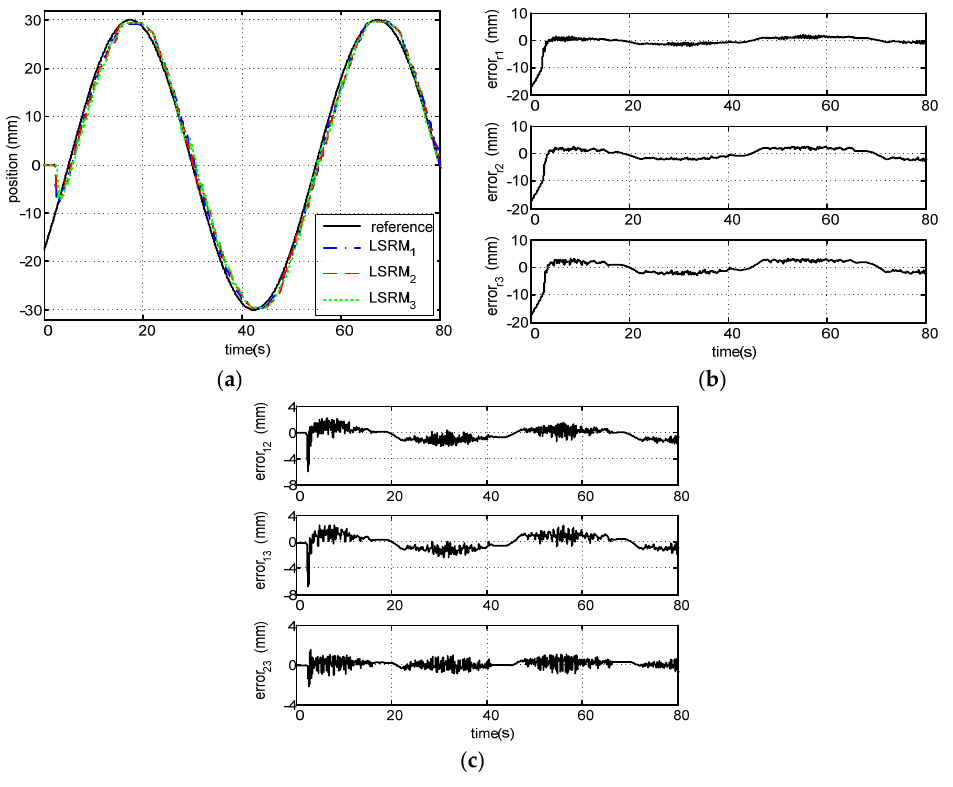
Figure 7. Tracking profiles ( a ) LSRMs; ( b ) error response to reference; and ( c ) relative error response between LSRMs with leader ‐ based feedback.